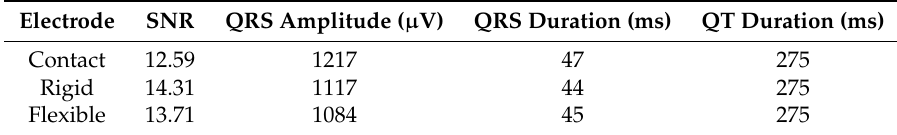
Table 2. Extracted parameters from electrocardiogram (ECG) and contactless electrocardiogram (cECG) simultaneous acquisition: signal-to-noise ratio (SNR), QRS and QT amplitude and